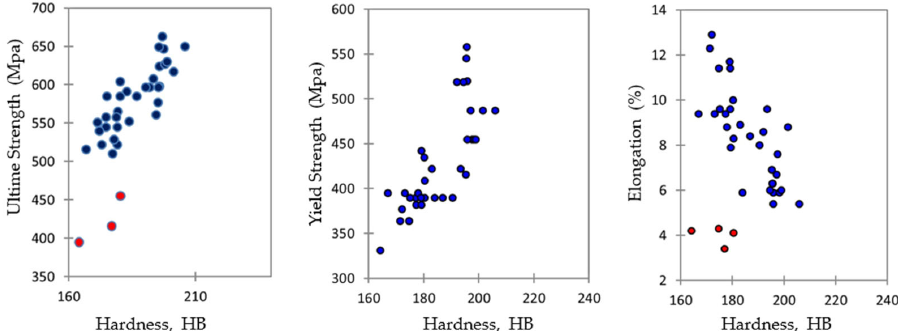
Figure 10. Mechanical properties (i.e., hardness ( HB ), yield strength ( YS ), tensile strength ( UTS ) and elongation ( ε )) as a function of the microstructure (i.e., ferrite, pearlite and graphite contents).